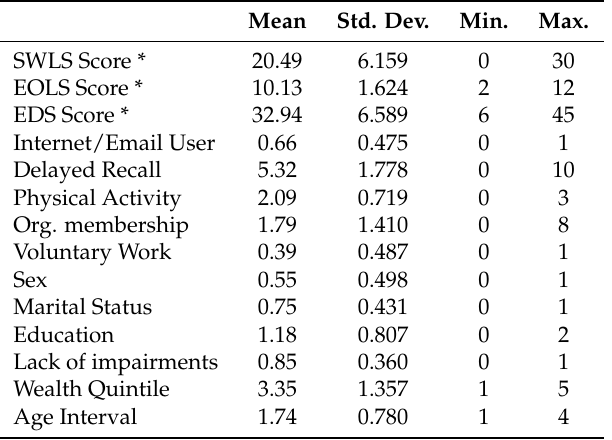
Table 1. Baseline characteristics of the analytical sample measured at Wave 3. English Longitudinal Study of Aging 2006–2007. Main descriptive statistics.